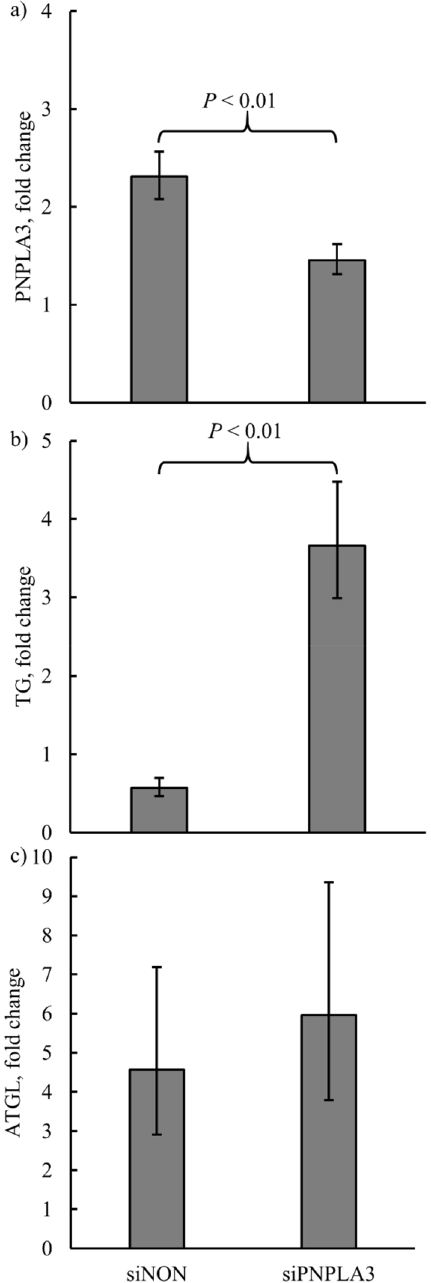
Figure 6. Fold changes in patatin-like phospholipase domain-containing protein 3 (PNPLA3) protein abundance ( a ), cellular triglyceride (TG; b ) content, and adipose triglyceride lipase protein (ATGL) abundance ( c ) in cells transfected with a nonspecific small interfering RNA (siNON) or a PNPLA3 specific small interfering RNA (siPNPLA3) relative to basal media treated cells (double negative control). Error bars represent 68% confidence limits of the back-transformed least squares